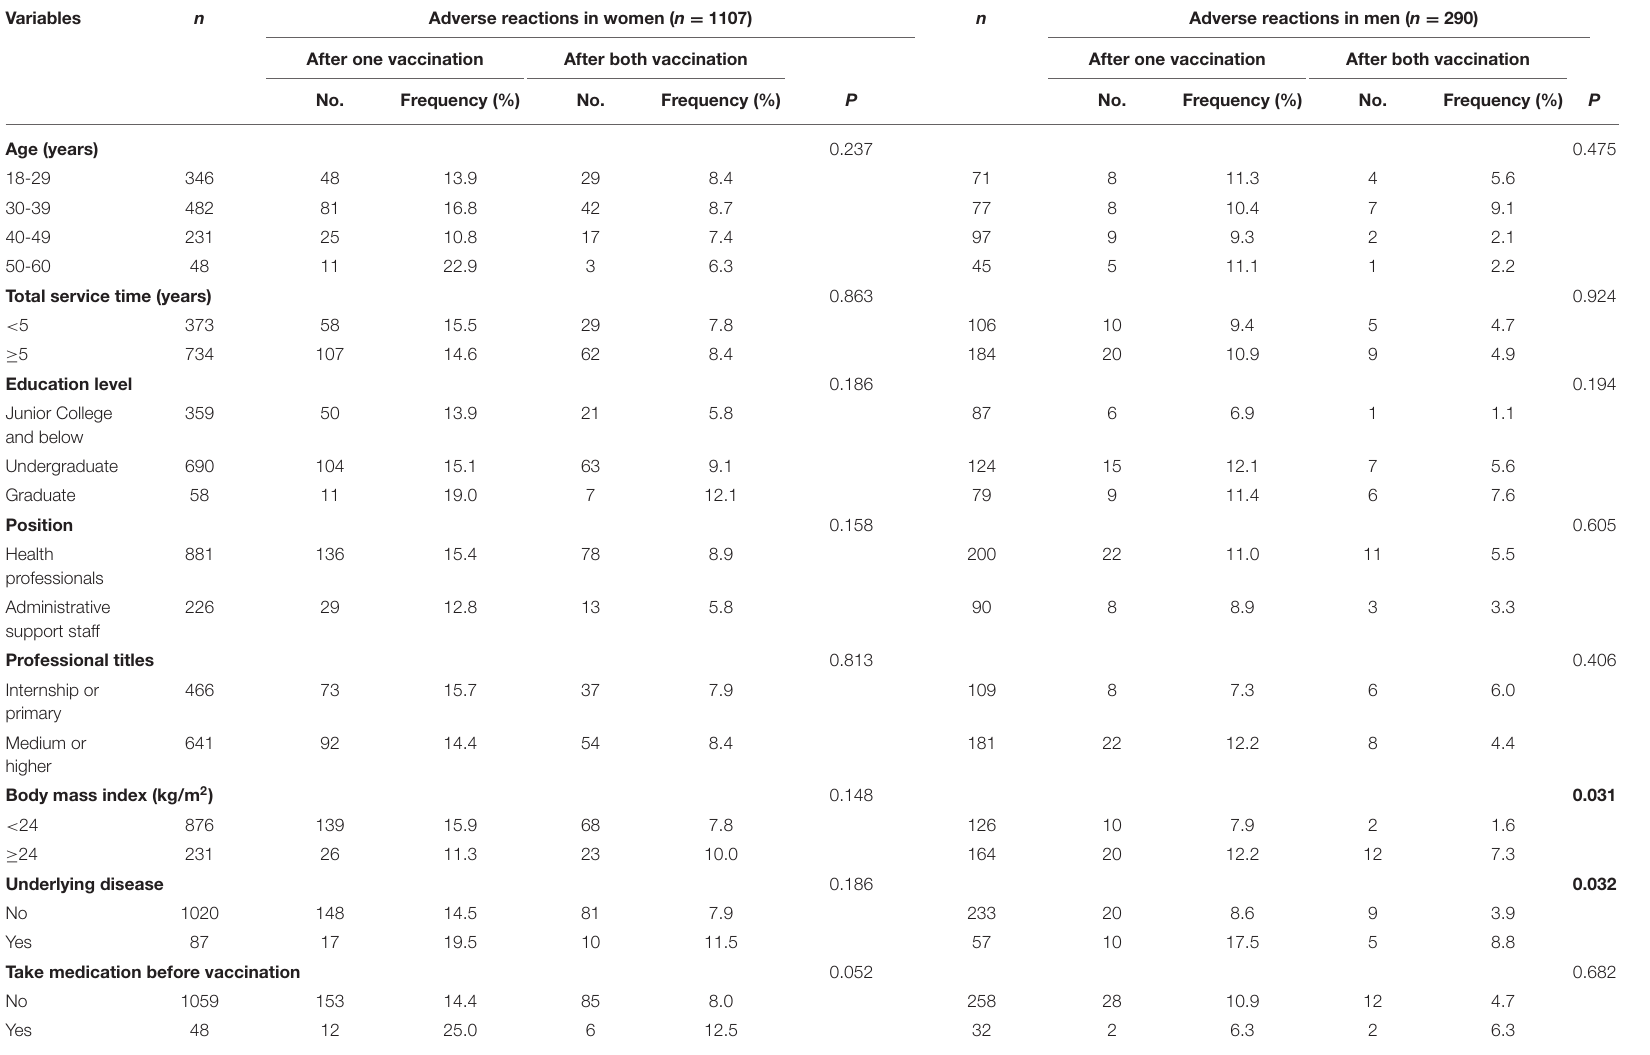
TABLE 2 | Univariate analysis of associated factors for adverse reactions in women and men.